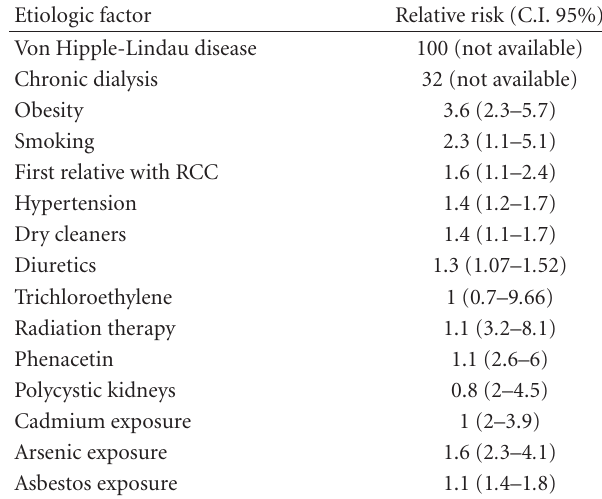
Table 3: Some etiologic factors of RCC